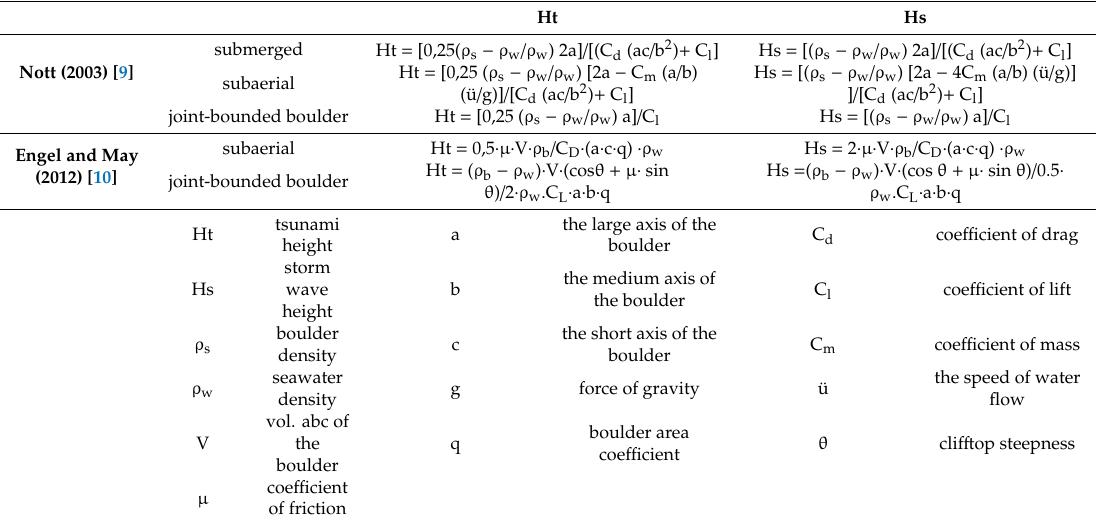
Table 3. Equations used in the analysis of Ibiza and Formentera boulders. ρ s = 1.9 g / cm 3 for Quaternary boulders and 2.3 g / cm 3 for Jurassic boulders, ρ w = 1.027 g / mL, C d = 2, C l = 0.178, C m = 2, ü = 1 m / s 2 , µ = 1, q = 0.73. Coe ffi cient values according to